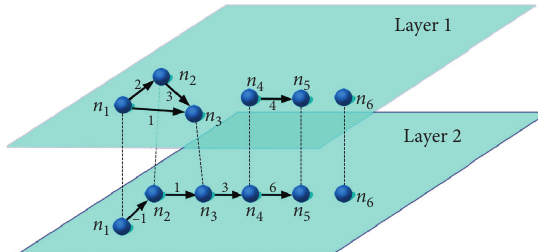
Figure 9: Initial status of 6 nodes in multiplex network with 2